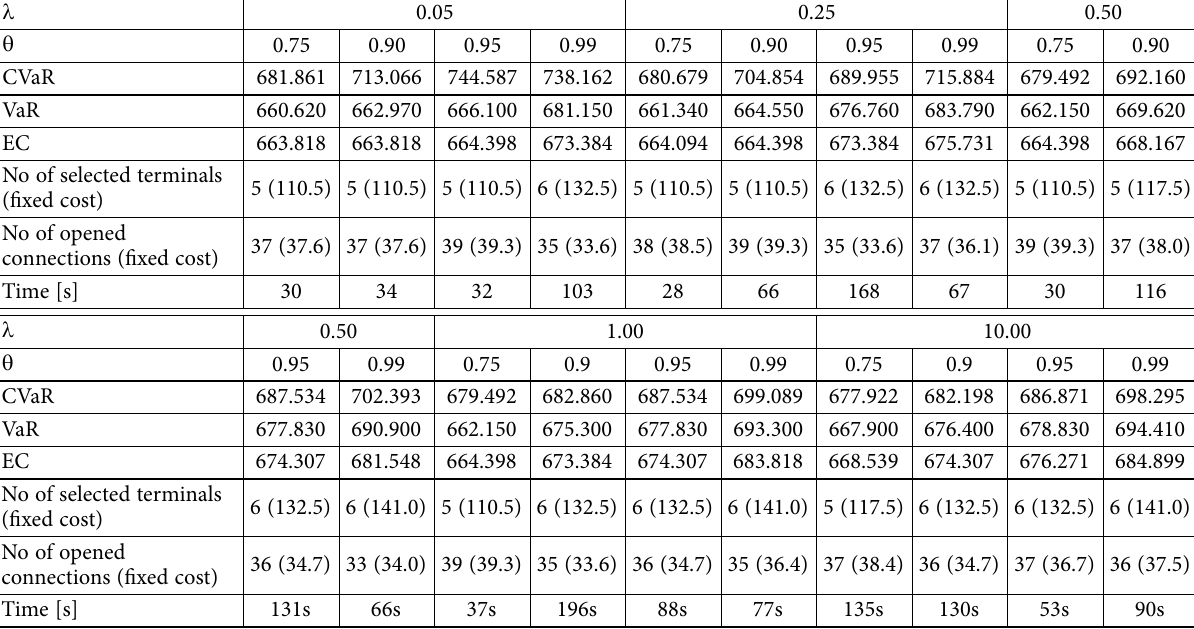
Table 5. Solutions of 2-stage MR model for case 8–2 (cost [$10 5